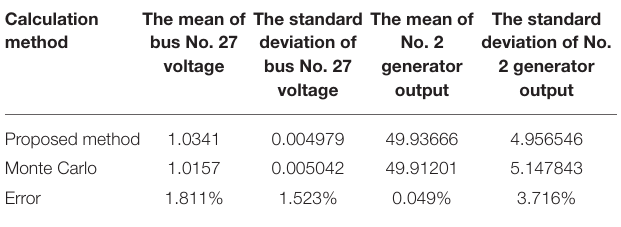
TABLE 2 | The results of probabilistic optimal power flow.